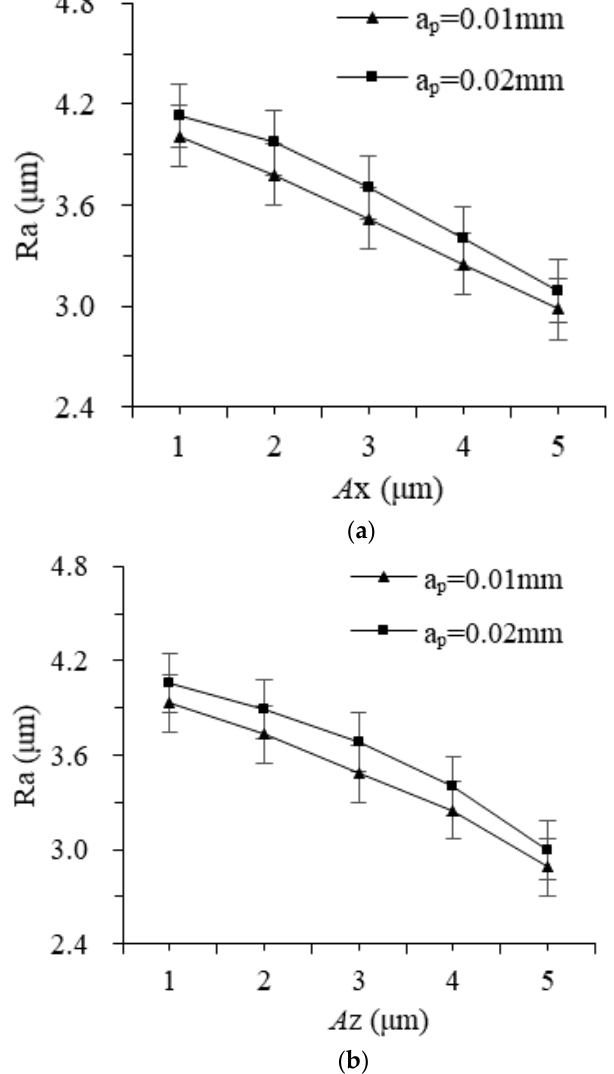
Figure 10. The effect of different amplitudes on surface roughness: ( a ) amplitude of workpiece and ( b ) amplitude of tool.